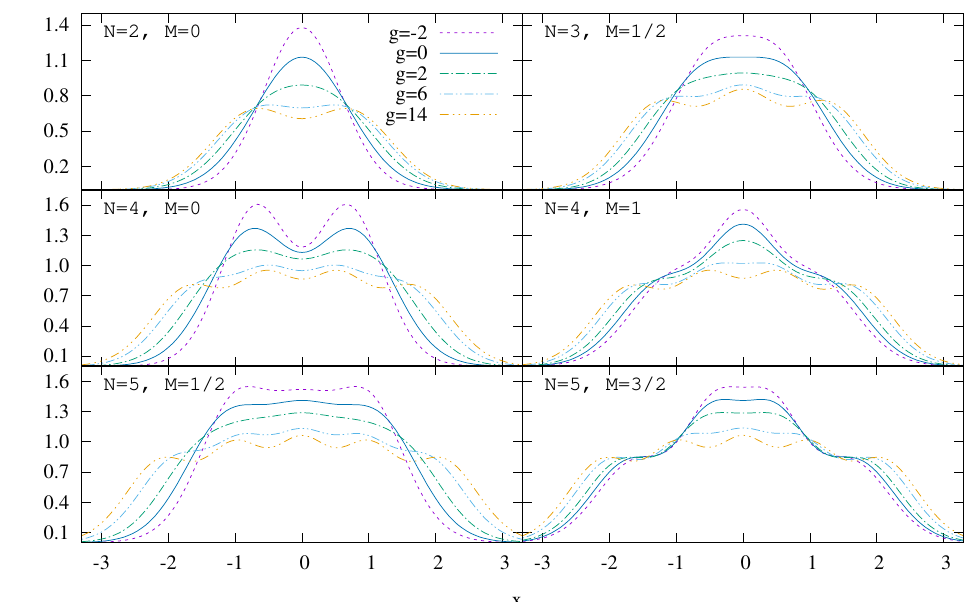
Figure 5. Density profiles of the ground state for different number of particles and spin projections. The density profiles are shown for various values of the interaction strength. The legend is common to all